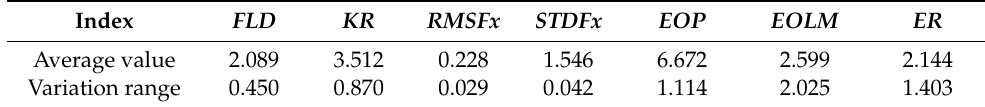
Table 6. Useful features of the surge velocity signal.